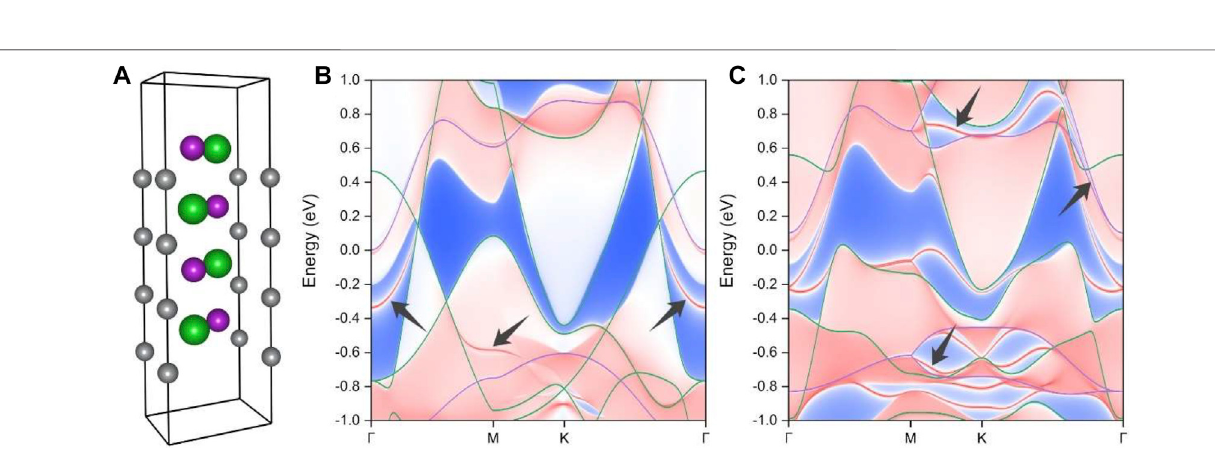
Frontiers in Chemistry |